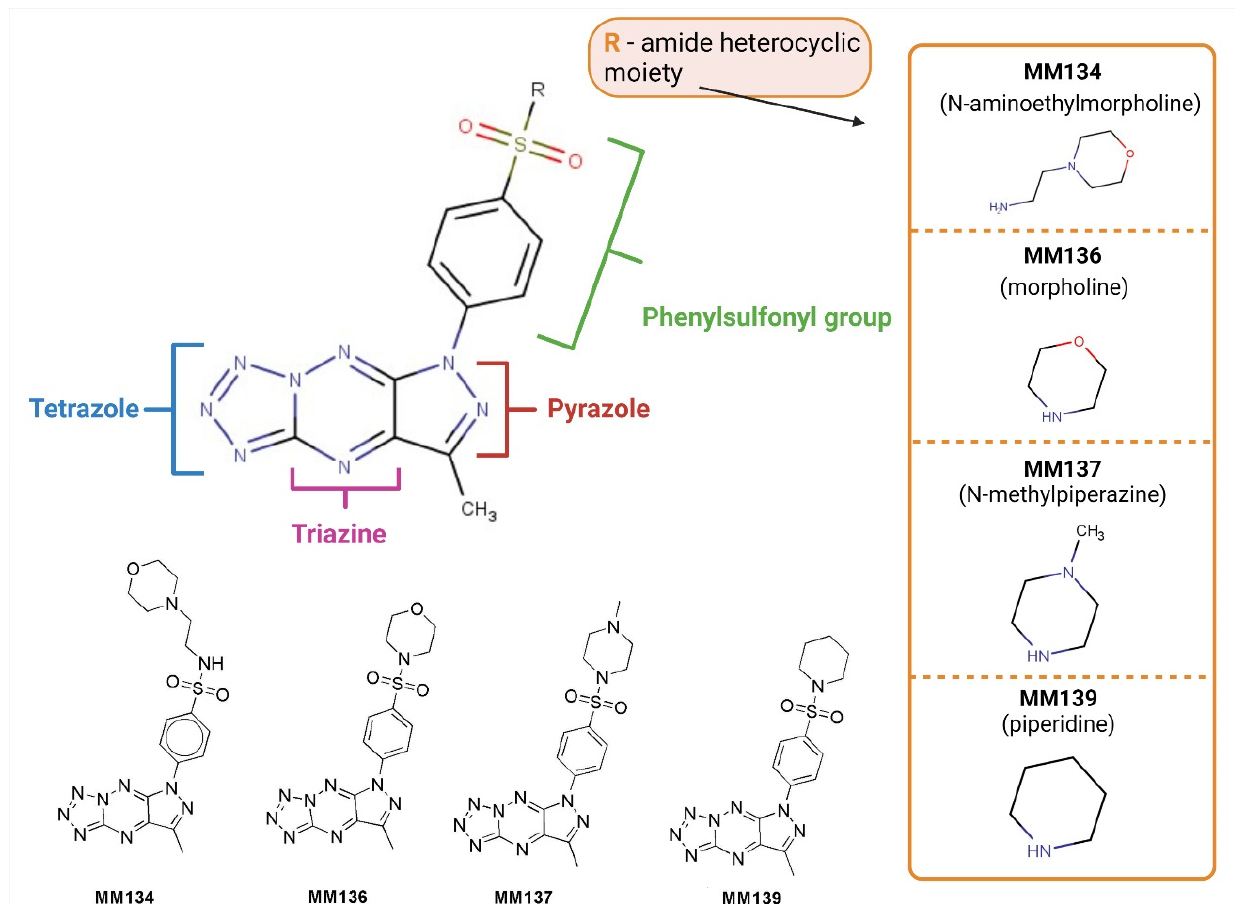
Figure 1. Chemical structure of investigated sulfonamides MM134 , MM136 , MM137 , and MM139 . Created with Biorender.com.